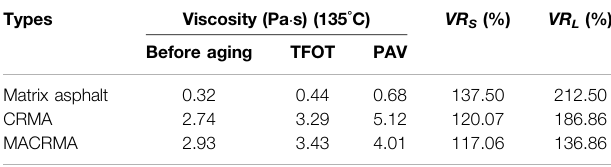
TABLE6| Viscositytestresultsofthreekindsofasphaltsatdifferentagingstages.